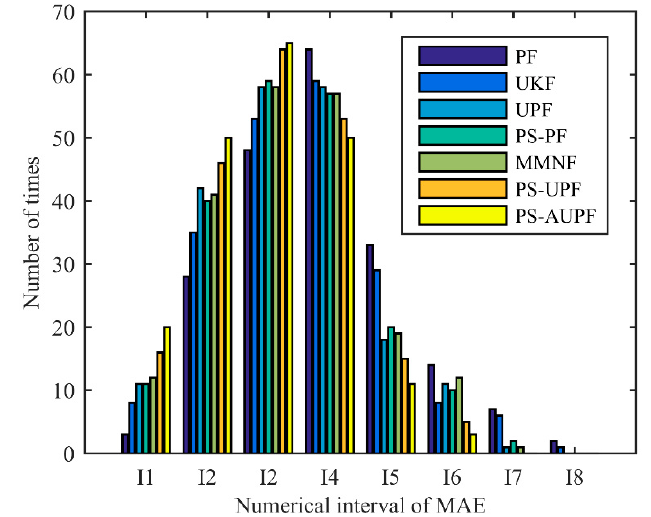
Figure 7. The mean absolute error (MAE) distribution of the estimated target position.